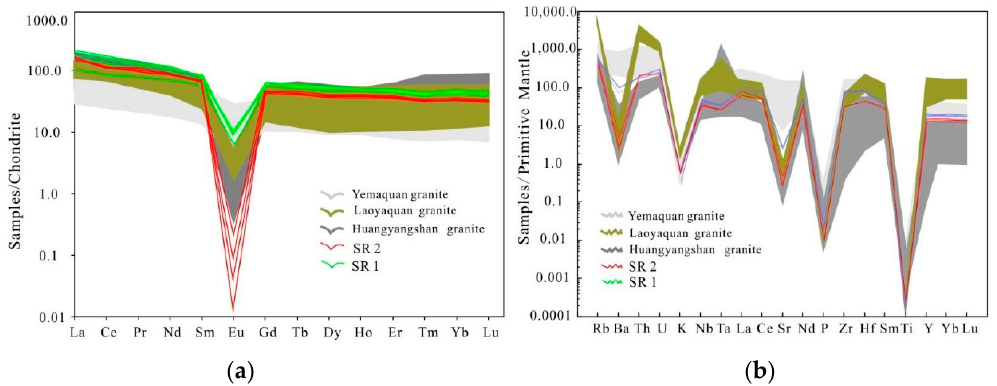
Figure 5. ( a ) Primitive mantle-normalized trace element and ( b ) chondrite-normalized REE patterns of the SR2 and SR1 in the Sayashk Sn deposit. Huangyangshan granite after [58], Laoyaquan granite after [9], Yemaquan granite after [59].